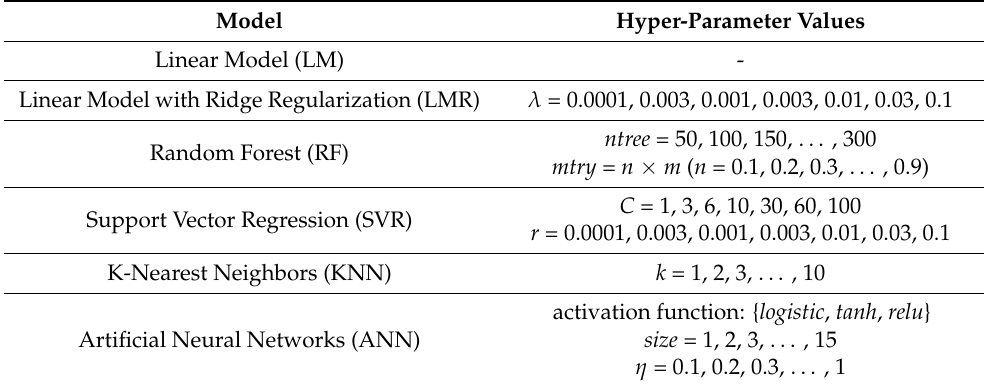
Table 4. Tested hyper-parameters for each machine learning algorithm. Model Hyper-Parameter Values Linear Model (LM) Linear Model with Ridge Regularization (LMR)